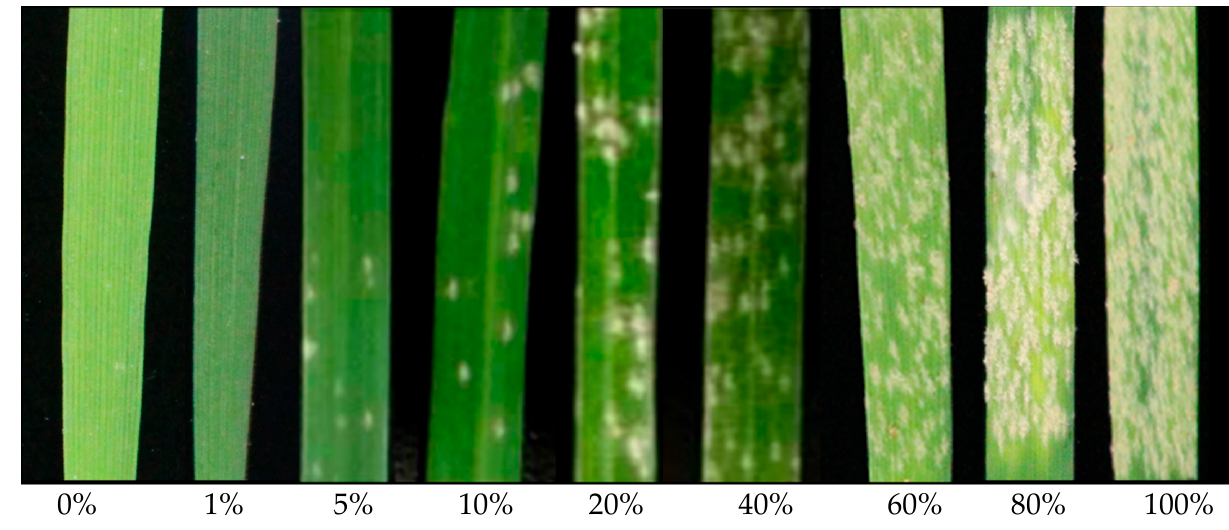
Figure 1. Images of wheat leaves with different DS.